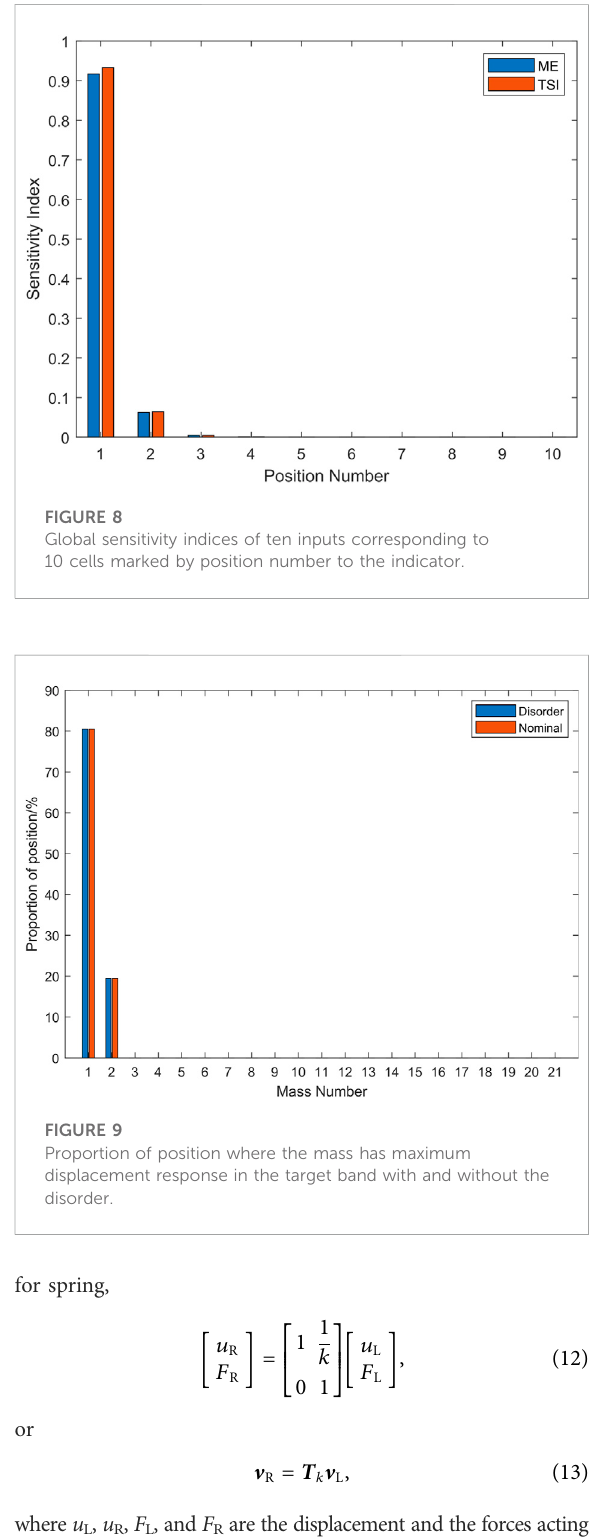
where u L , u R , F L , and F R are the displacement and the forces acting on the left and right ends, m and k are the parameters of mass and spring, v L and v R are the state vectors of left and right ends, T m and T k are the transfer matrix of mass and spring, respectively.